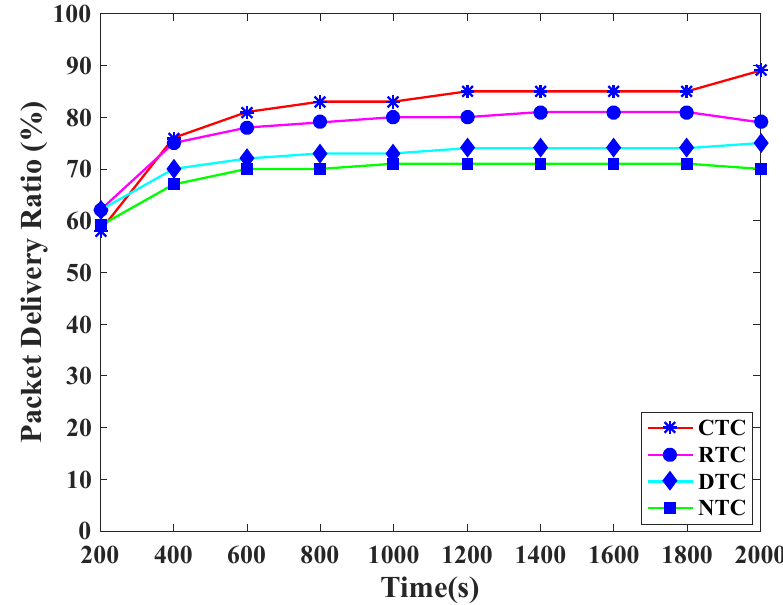
Figure 9. Packet delivery ratio versus time in seconds.